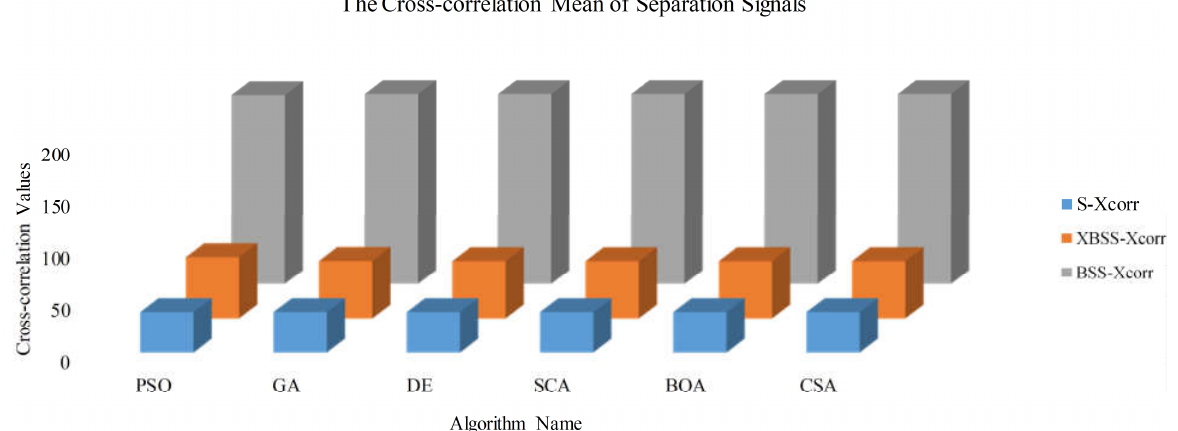
Figure 9. The mean cross-correlation value of separated signals obtained by the SI-BSS and SI-XBSS. (S-Xcorr was the cross-correlation value of source signals. XBSS-Xcorr was the cross-correlation value